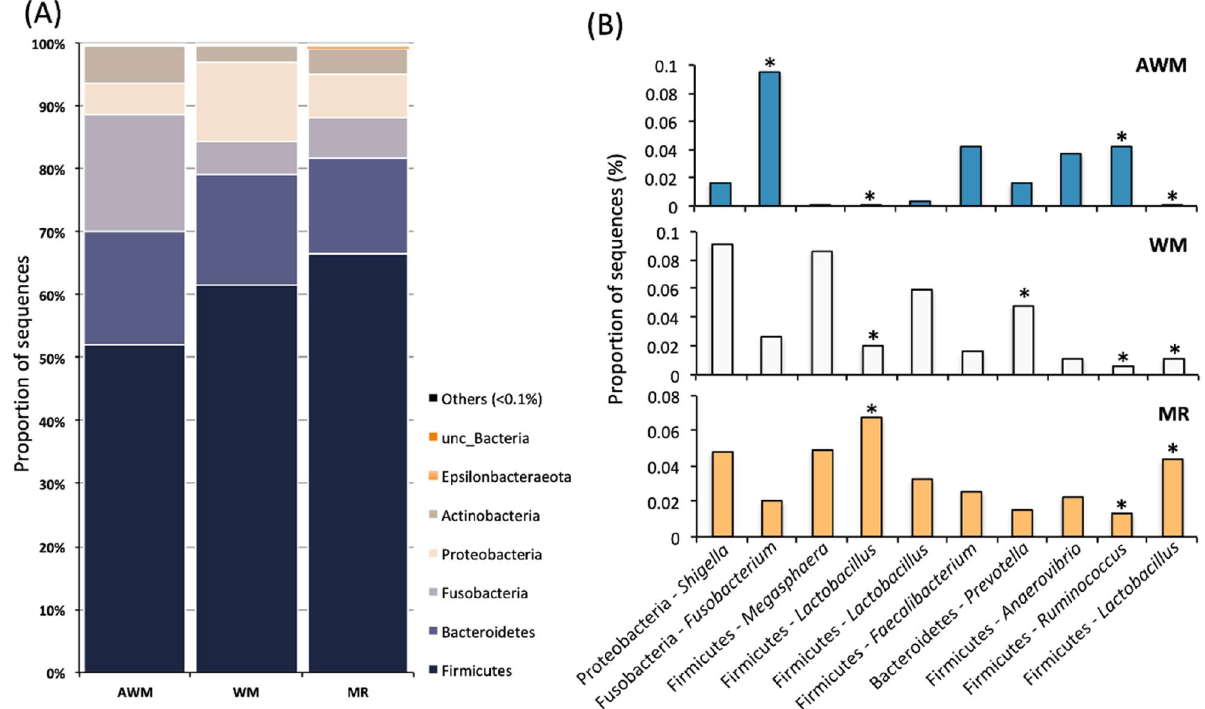
Figure 4. Bacterial composition in diarrheal fecal samples from dairy calves fed different liquid diets. ( A ) General phylum abundance; and ( B ) Top 10 most abundant ASVs. *Denotes statistical difference of P < 0.05 for higher abundance of Fusobacteirum for AWM; higher abundance in MR and the lowest in AWM for LL actobacillus ; higher abundance of Prevotella for WM; and highest abundance of Ruminococcus in AWM and lowest in